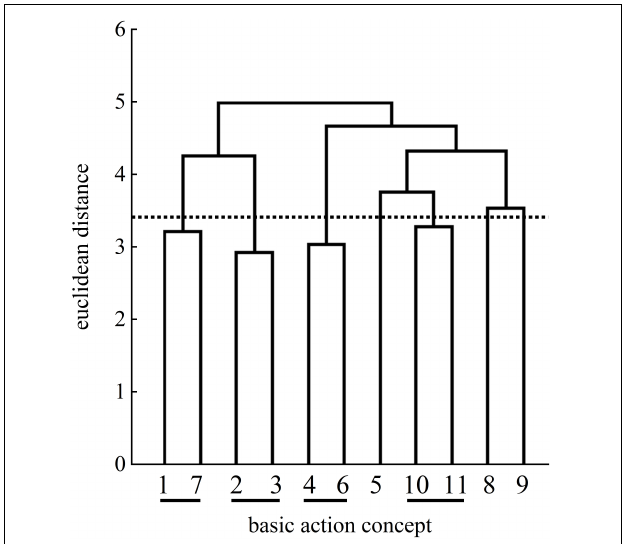
FIGURE 10 | Mean group dendrogram of the control group’s ( n = 14) tennis serves on the pretest.